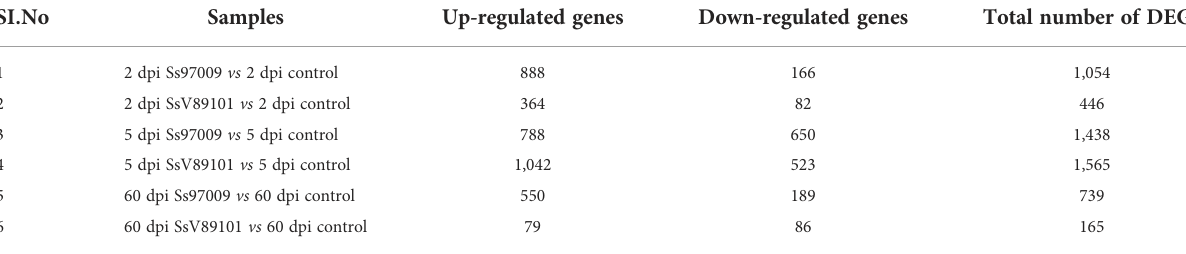
TABLE 1 Differentially expressed genes between pairwise sample combinations.